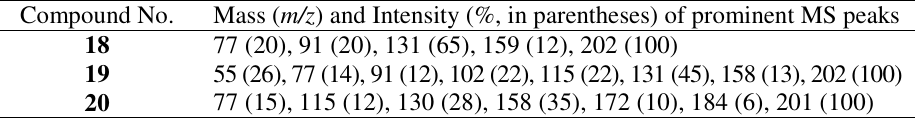
Table 2 . Mass spectral data of unknown compounds listed in Table 1 Compound